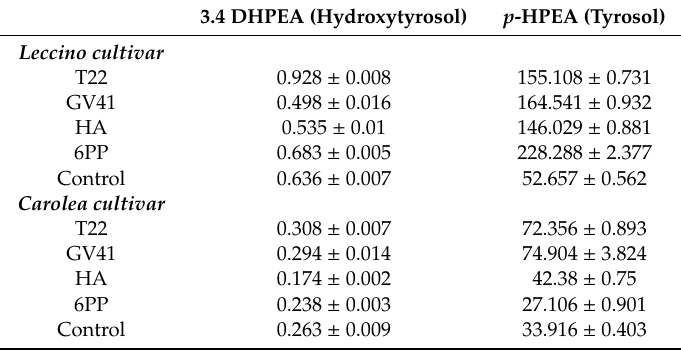
Table 4. Content of phenolic alcohols in EVOO (mg /